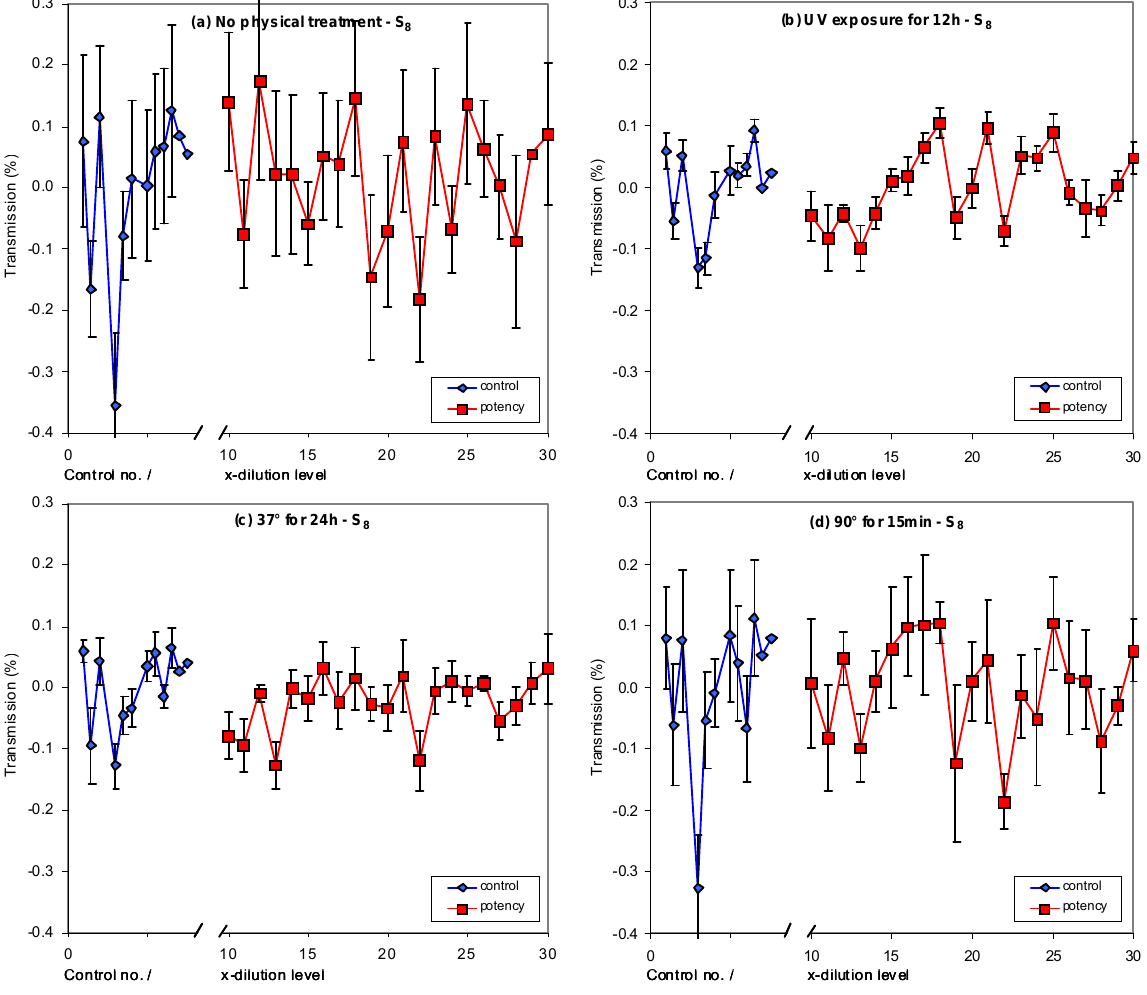
FIGURE 2. S 8 homeopathic preparations and controls: (a) without exposure to physical treatment (day 26, ns), (b) after exposure to 12 h UV light (ns), (c) after 24 h incubation at 37ºC (ns), and (d) after 15 min heating to 90ºC in a water bath